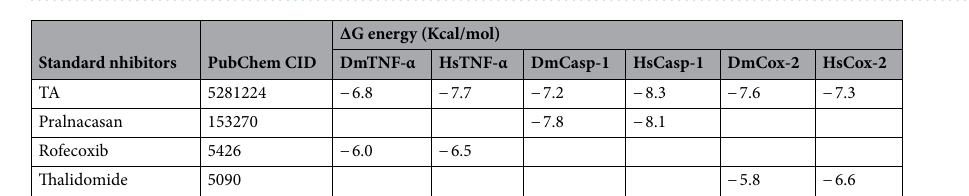
Figure 5. Effects of TA (1.0 mg/10 g diet) and/or rotenone (500 μM) on emergence rate ( A ), and acetylcholinesterase activity ( B ). Data in ( A – C ) are presented as Mean ± SEM of 50 flies per vial (five replicates per group). a: Significant difference compared with control group; b: Significant difference compared with rotenone group (p < 0.05). TA trans-astaxanthin.